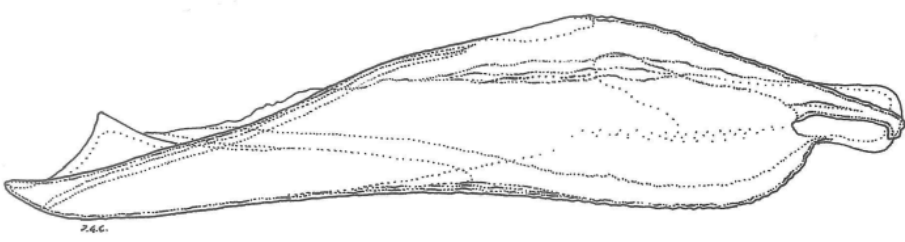
Figure 10. Valva of male genitalia of P. lurae sp. nov (G. Coutsis prep.